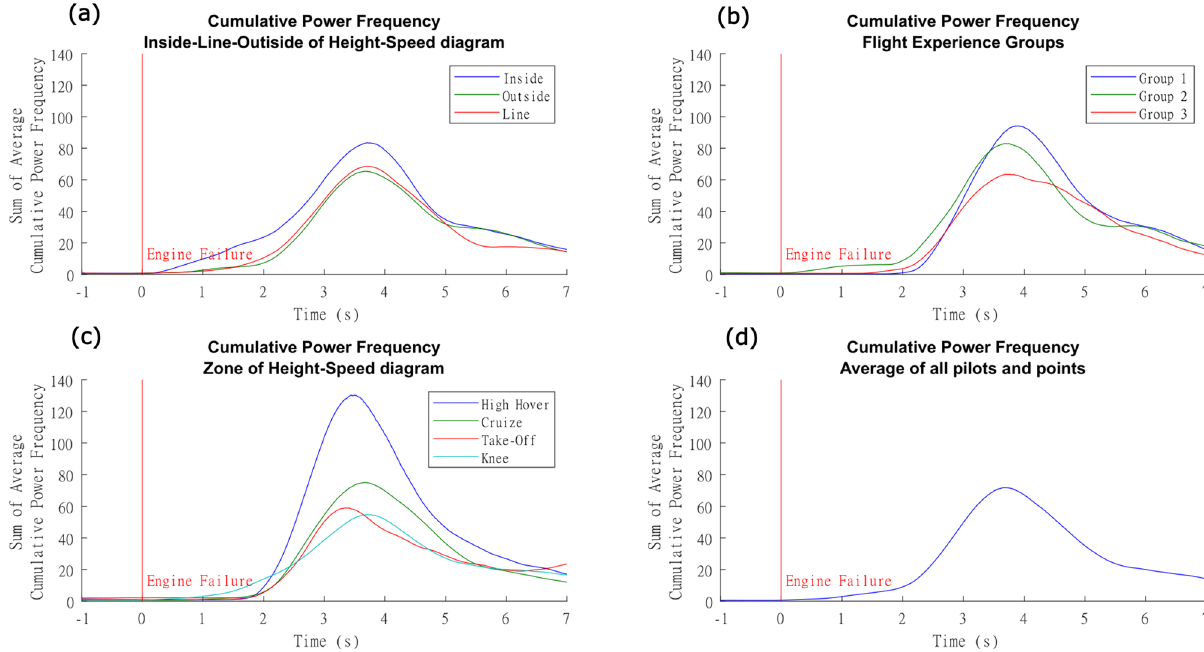
Figure 5. Cumulative Power Frequency of helicopter pilots carrying out in flight autorotation at height-speed diagram. (a) Pilots’ mean CPF at each phase of the classical partition of the height-speed diagram (inside, outside or at the line limit). (b) Mean cumulative CPF of different groups of pilots according to their previous experience: Group 1 (test pilots with extensive autorotation experience), Group 2 (test pilots with